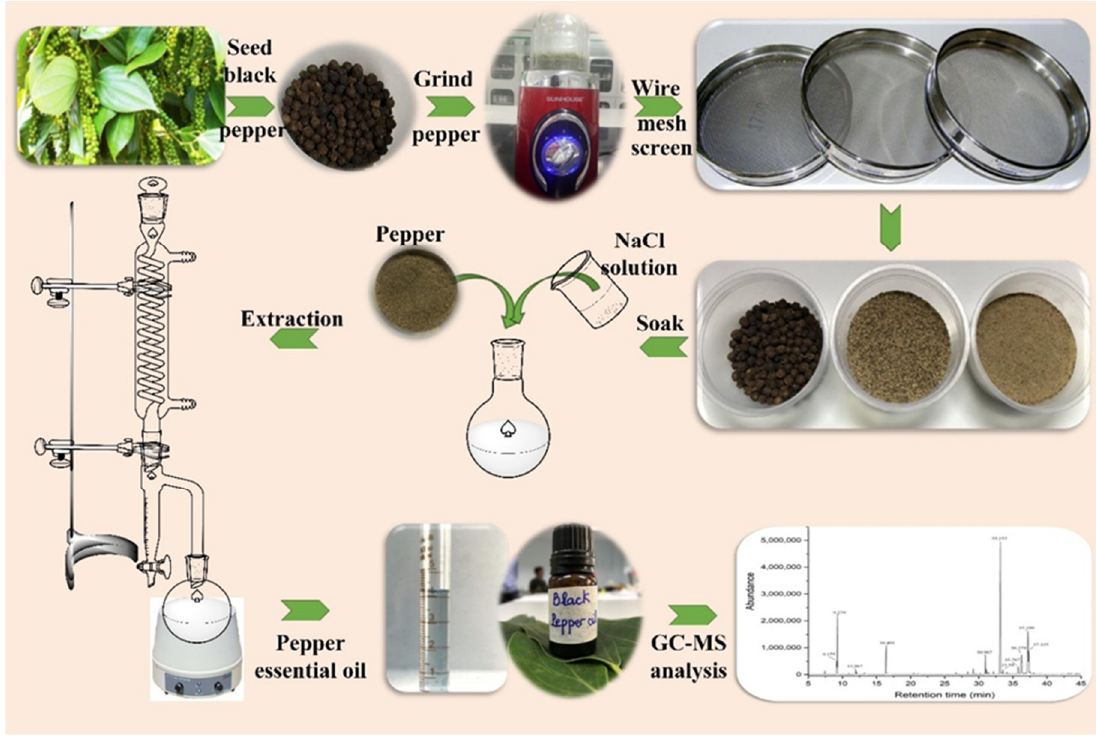
Figure 1. The process of black pepper essential oil extraction by hydro-distillation.